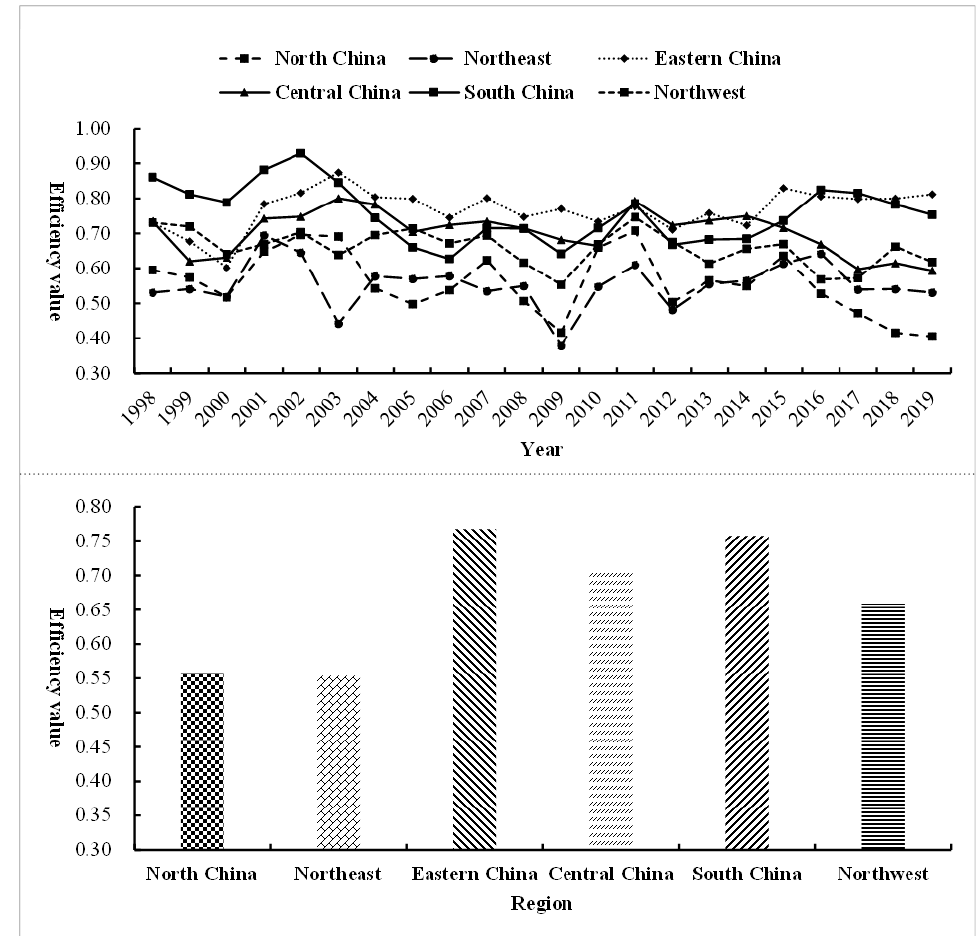
Figure 5. Comparison of the comprehensive level of environmental efficiency in six regions of China. The main reasons for the above changes are as follows: in 2004, the electric power industry implemented a series of environmental protection policies, such as “scale the large and suppress the small” and desulfurization and denitrification”, which promoted the management and technical level of power enterprises and then affected the environ- mental efficiency to varying degrees. Due to the global economic crisis at the beginning of 2007 and the downward pressure on the global economy in 2012, the environmental effi- ciency of the power industry showed a downward trend. Although the reform goal of “Circular No. 5” of electric power was to improve efficiency, optimize resource allocation, and promote power development, domestic enterprises were in a shrinking market, and the efficiency improvement of the power generation link and the transmission and distri- bution network link was limited. Therefore, the development of the power industry and the improvement of the management level of power enterprises had been affected to a considerable extent, and a healthy development of a coordinated and orderly power mar- ket system had not been constructed. The new round of power system reform in 2015 relatively effectively promoted the improvement of environmental efficiency in most re- gions. However, due to unreasonable internal structure and resource allocation, some re- gions could not adapt to the effects of reform policies. From 1998 to 2019, the overall change trend of the comprehensive level of environ- mental efficiency of the six regional power industries is roughly the same. However, the